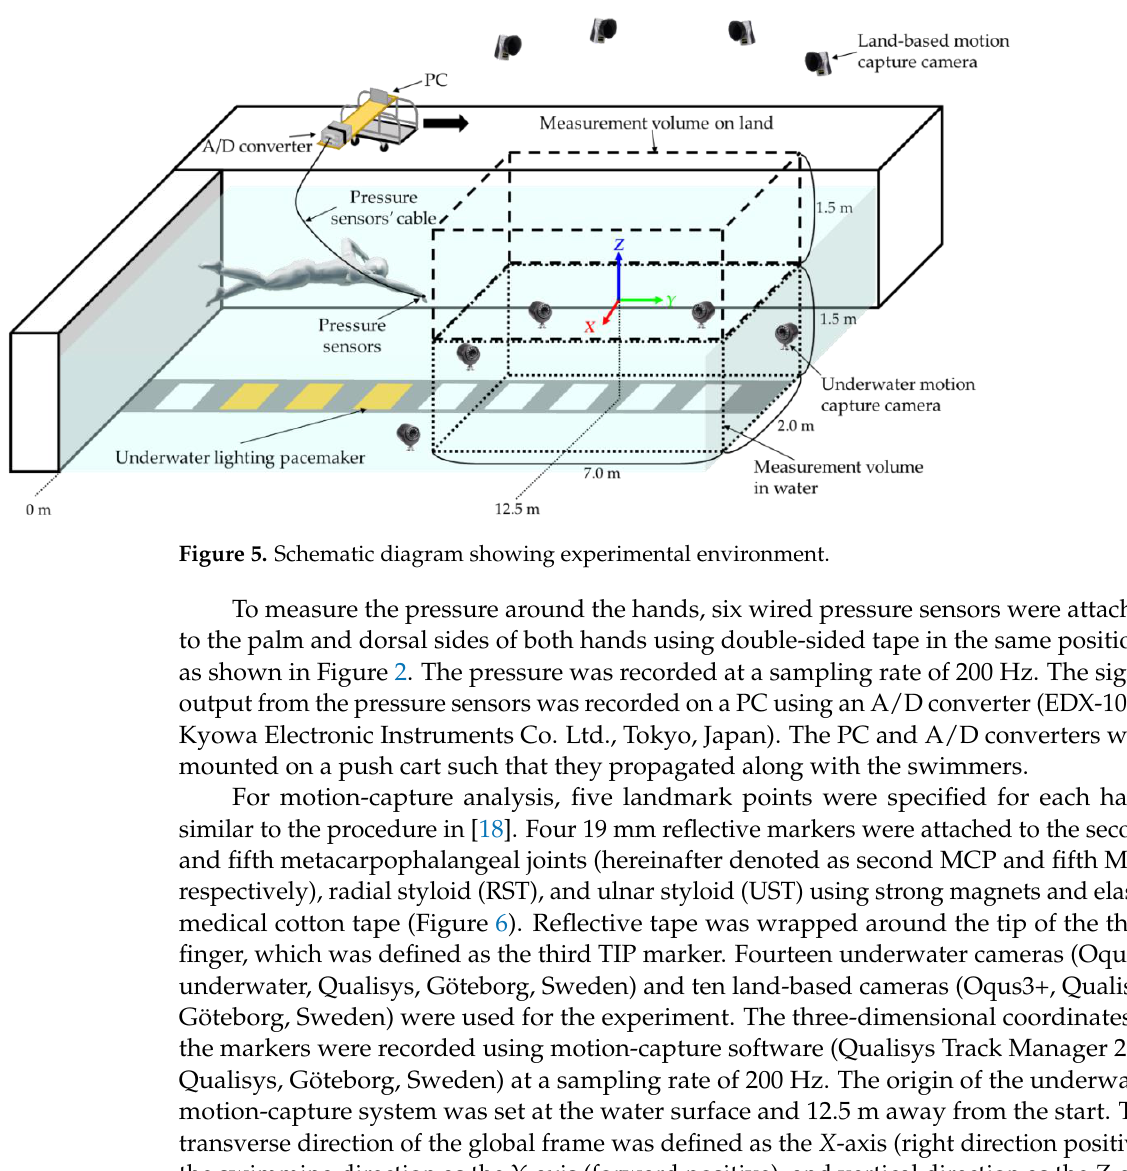
system and A/D converter simultaneously, and then, used for data synchronization in the